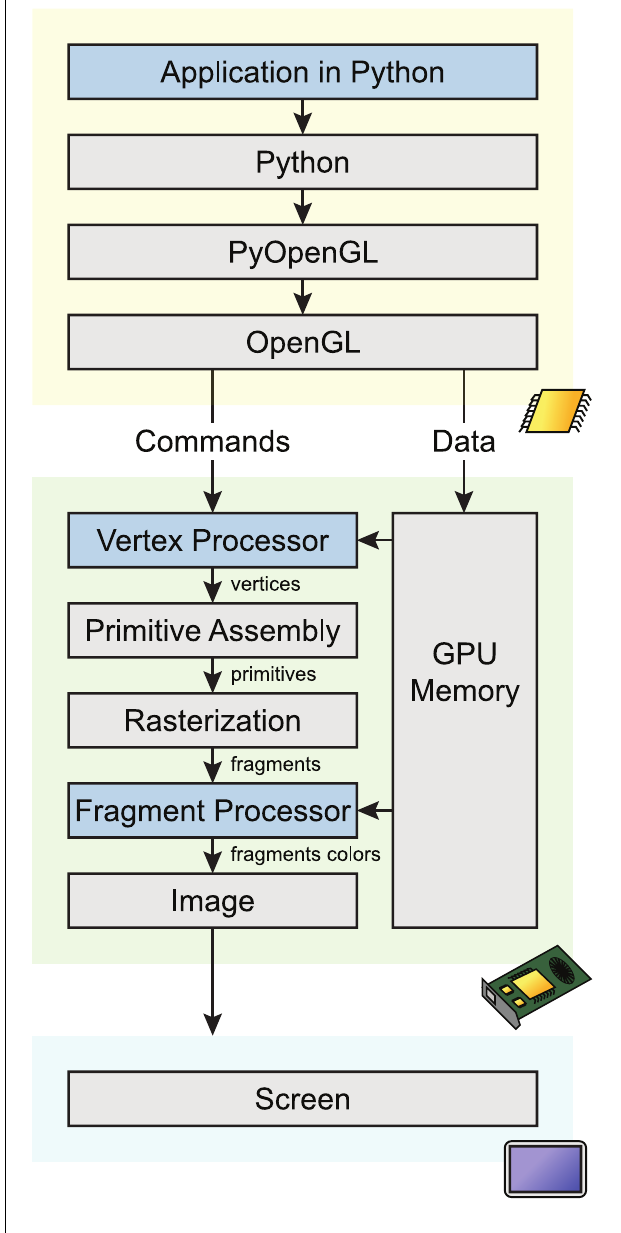
FIGURE 1 | Simplified OpenGL pipeline. Graphical commands and data go through multiple stages from the application code in Python to the screen. The code calls OpenGL commands and sends data on the GPU through PyOpenGL, a Python-OpenGL binding library. Vertex shaders process data vertices in parallel, and return points in homogeneous coordinates. During rasterization, a bitmap image is created from the vector primitives. The fragment shader processes pixels in parallel, and assigns a color and depth to every drawn pixel. The image is finally rendered on